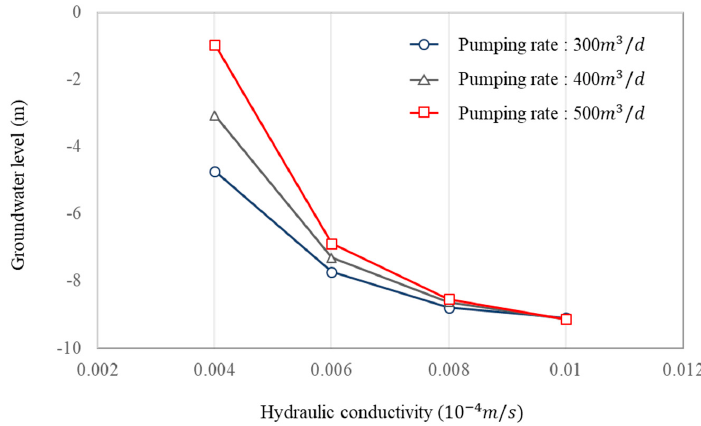
Figure 11. Groundwater level at the injection well in the condition of different hydraulic conductivities and pumping rates.